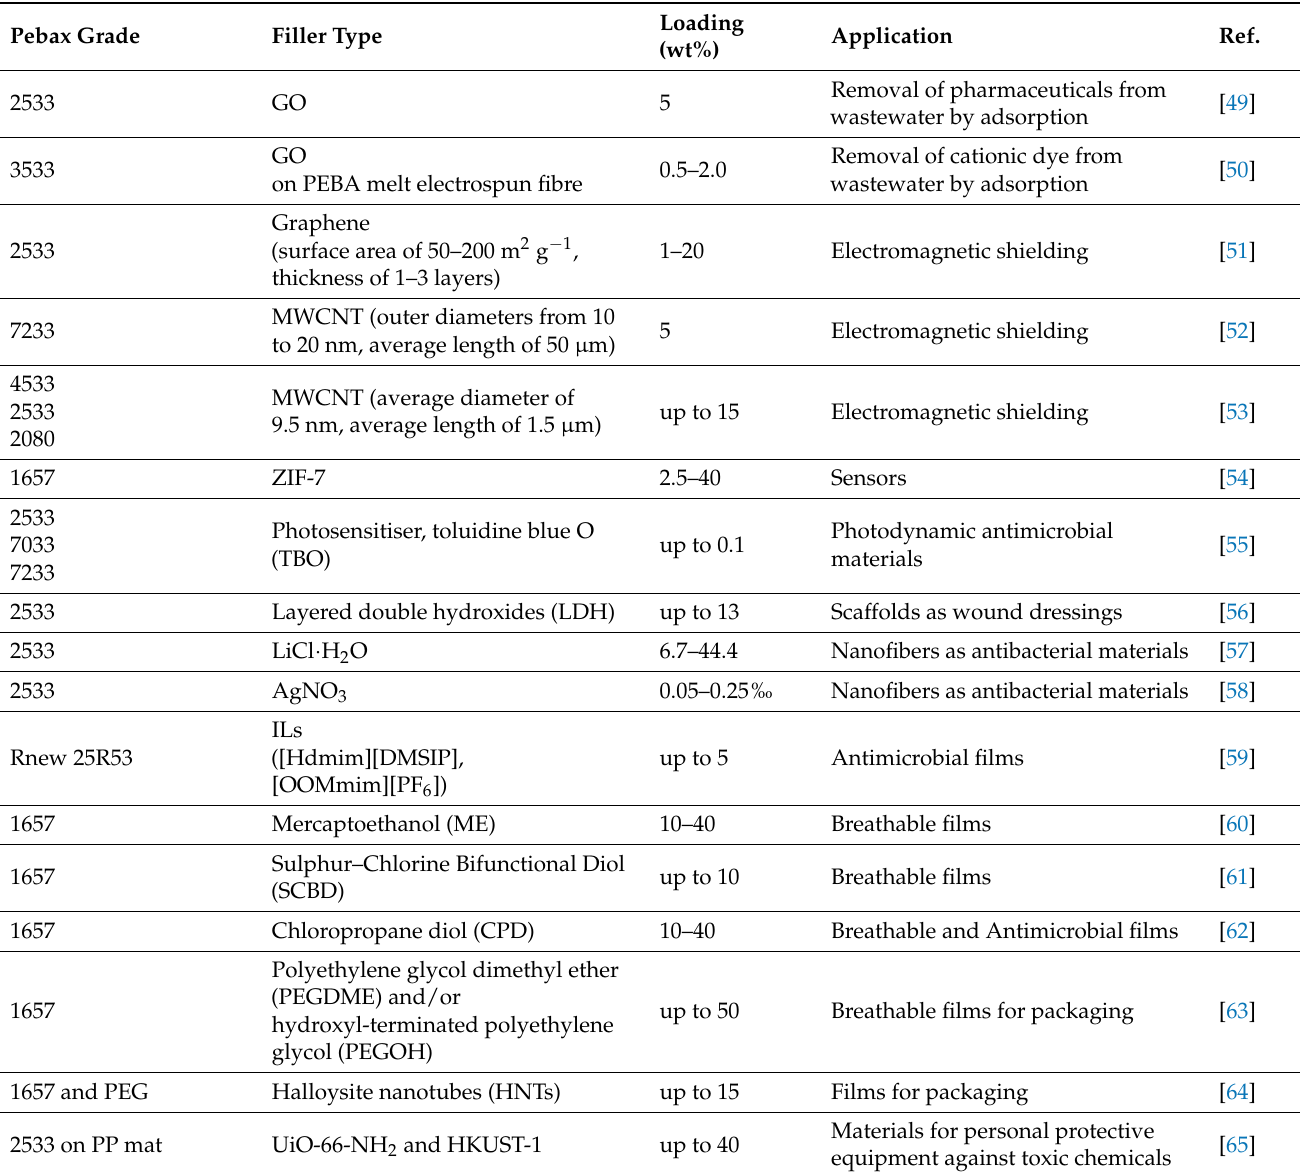
Table 3. Fillers utilized for developing Pebax-based nanocomposites as multifunctional